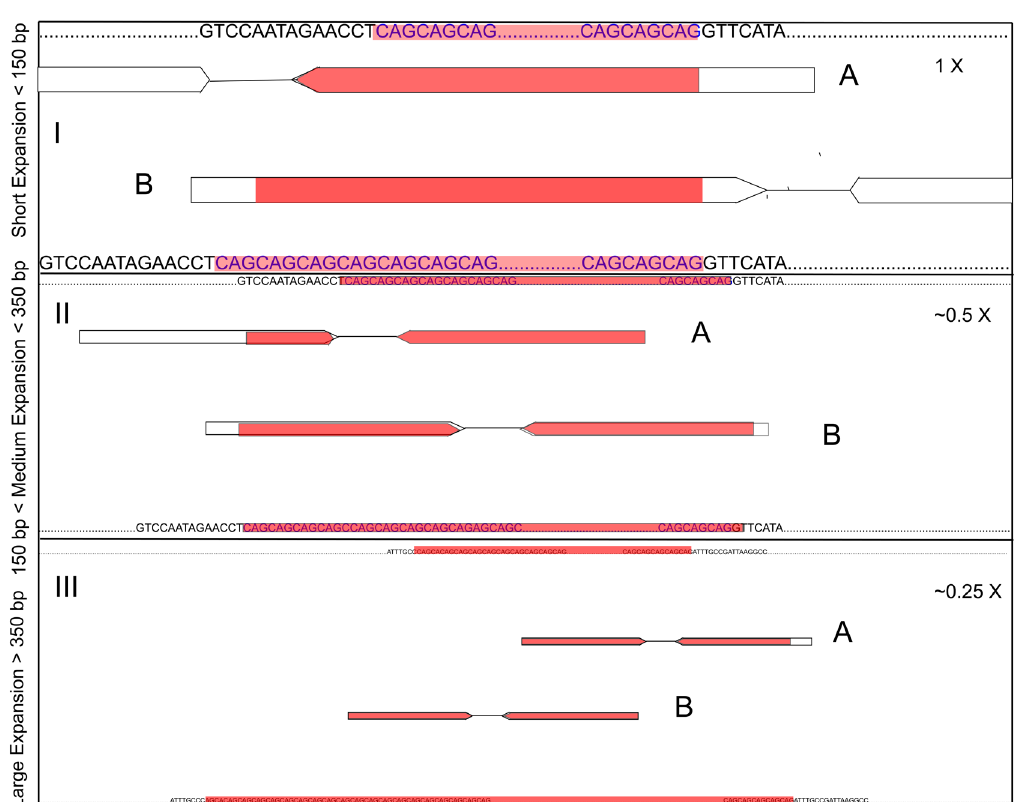
Figure 1. Detecting repeat expansions with short-read sequencing data. Depicted are three scenarios: ( I ) a short repeat expansion where the repeat expansion is less than 150 base pairs (bp), or smaller than a read; ( II ) a medium-size repeat expansion where the repeat expansion is between 150 and 350 bp; and ( III ) a large repeat expansion, where the repeat expansion is greater than 350 bp. For each of the three panels, I – III , the top line of DNA sequence depicts the reference sequence, and the bottom line depicts the (not known) repeat expansion size sequence. Red segments in reads signify repeat sequence. Evidence from reads varies according to the repeat size. For all three scenarios, there is information in reads that map into the repeat (A) but for scenario I occasional reads span the expanded allele (B), giving information about the size of the expanded allele. In scenario II , some read fragments can span expanded allele and can also be used for inference. For large expansions, some read fragments stem entirely from the expanded alleles. These may not be unambiguously mapped and are exploited only by ExpansionHunter (large motifs only) and TREDPARSE (based on fragment size